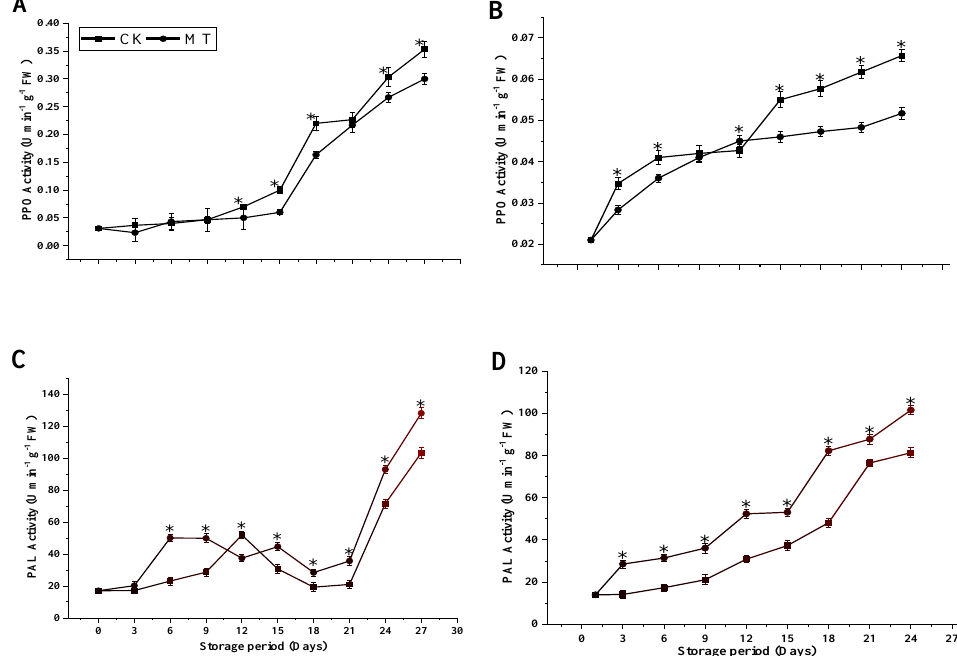
Figure 7. PPO activity ( A , B ) and PAL activity ( C , D ) of ‘Guiqi’ ( A , C ) and ‘Tainong 1’ ( B , D ) fruits treated with 1000 μmol L −1 MT. Each value is the mean for three replicates, and vertical bars indicate the standard error (SE). Error bars with an asterisk (*) on the same storage period show a significant difference between the treatments ( p < 0.05).